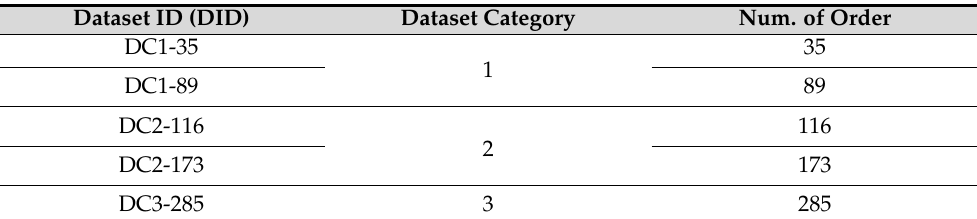
Table 6. Datasets for experiment